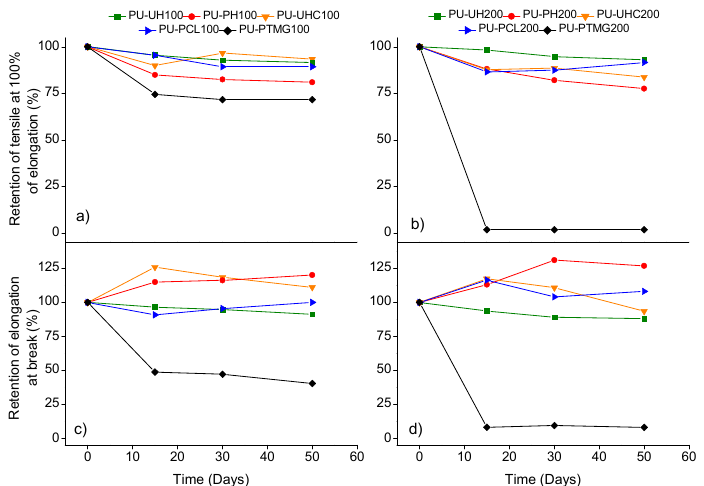
Figure 6. Durability test under heat resistance: ( a ) and ( b ), retention of tensile strength at 100% of elongation; ( c ) and ( d ), retention of elongation at break.